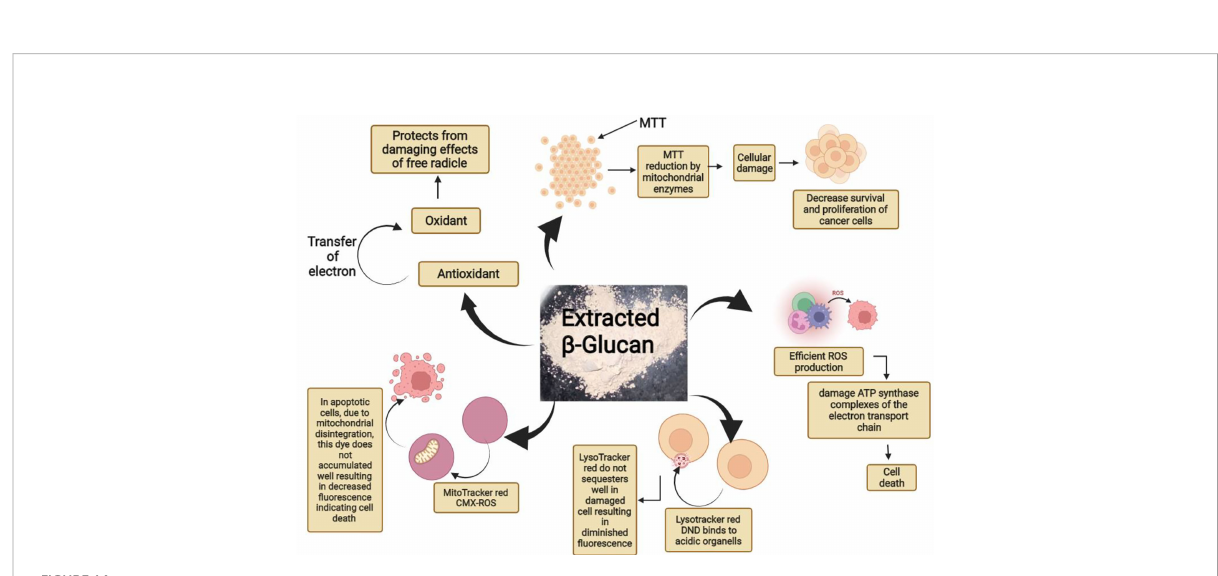
FIGURE 14 Graphical abstract showing various reported activities of b -glucan in our